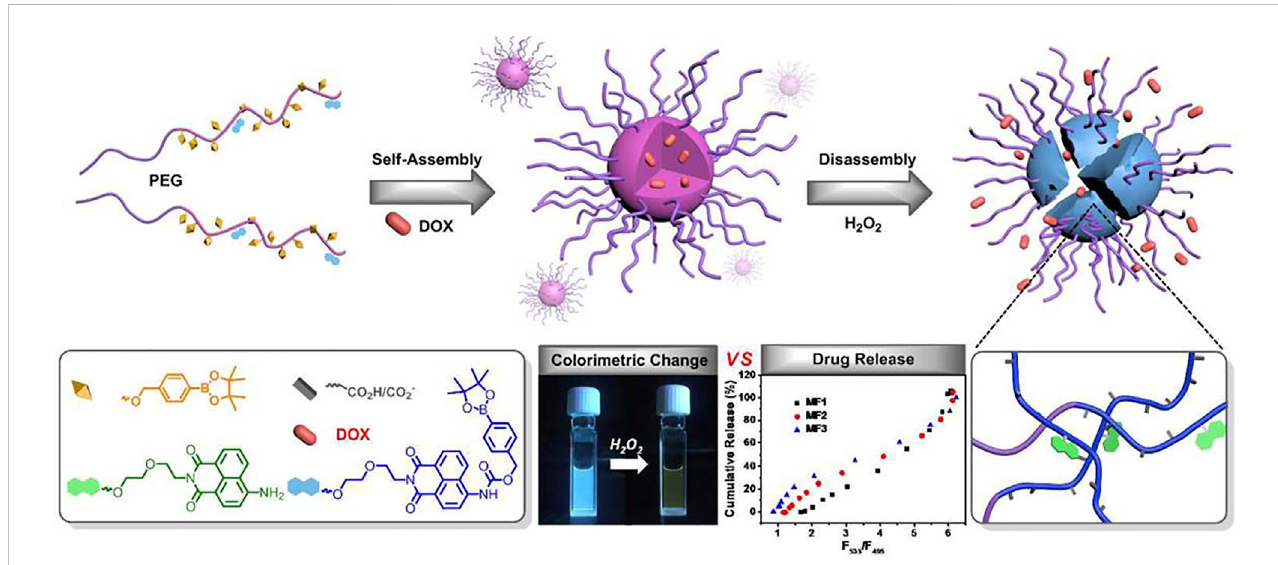
FIGURE 1 Schematic illustration of a kind of ROS-responsive NPs delivery system. Reproduced from Zhang et al. (2018), with permission from American Chemical